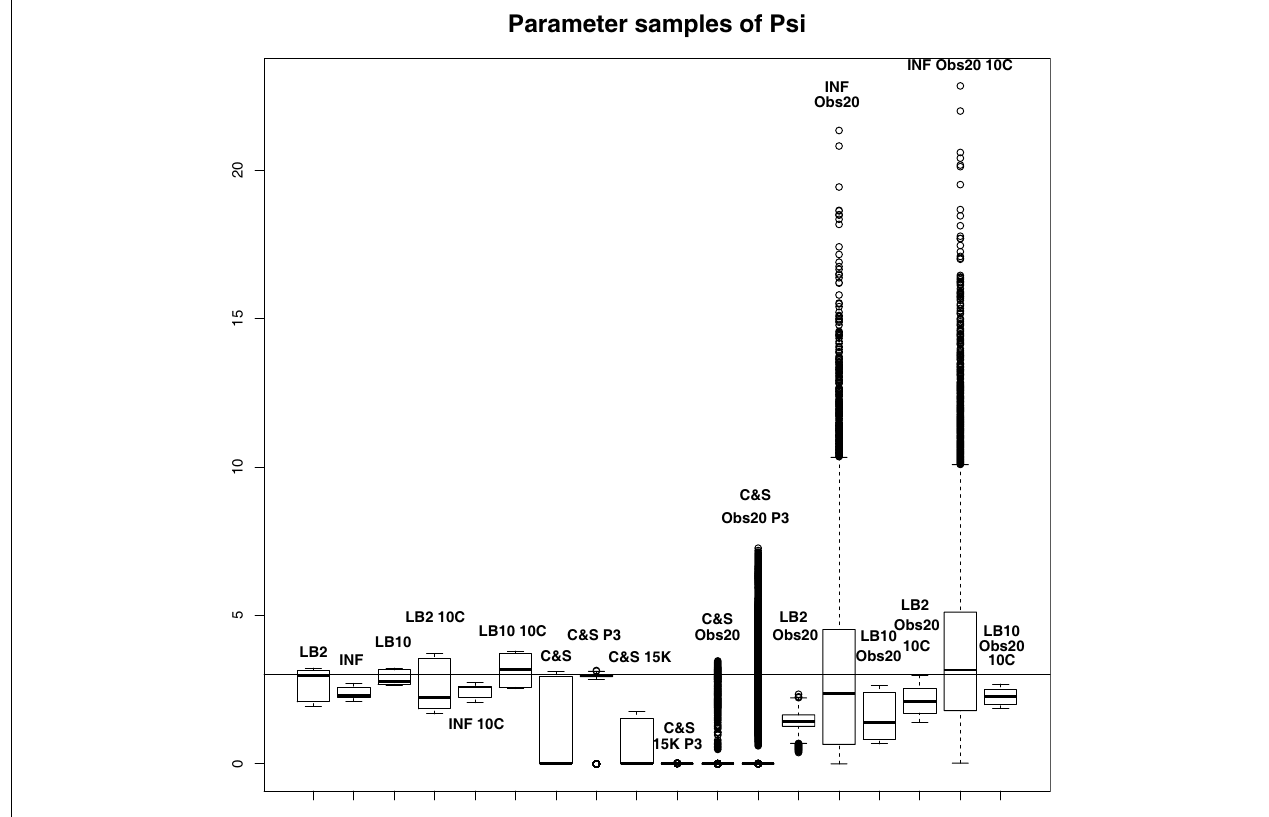
FIGURE 10 | Average posterior distributions of parameter from equation (62) over 3 datasets . From left to right: LB2, INF, LB10, LB2 10C, INF 10C, LB10 10C, C&S, C&S P3, C&S 15K, C&S 15K P3, C&S Obs20, C&S Obs20 P3, LB2 Obs20, INF Obs20, LB10 Obs20, LB2 Obs20 10C, INF Obs20 10C, and LB10 Obs20 10C. The solid line is the true parameter. For definitions, see Tables 3 and 4 . For an explanation of the boxplot form, see the beginning of Section 6. Figure reconstructed from Macdonald and Husmeier